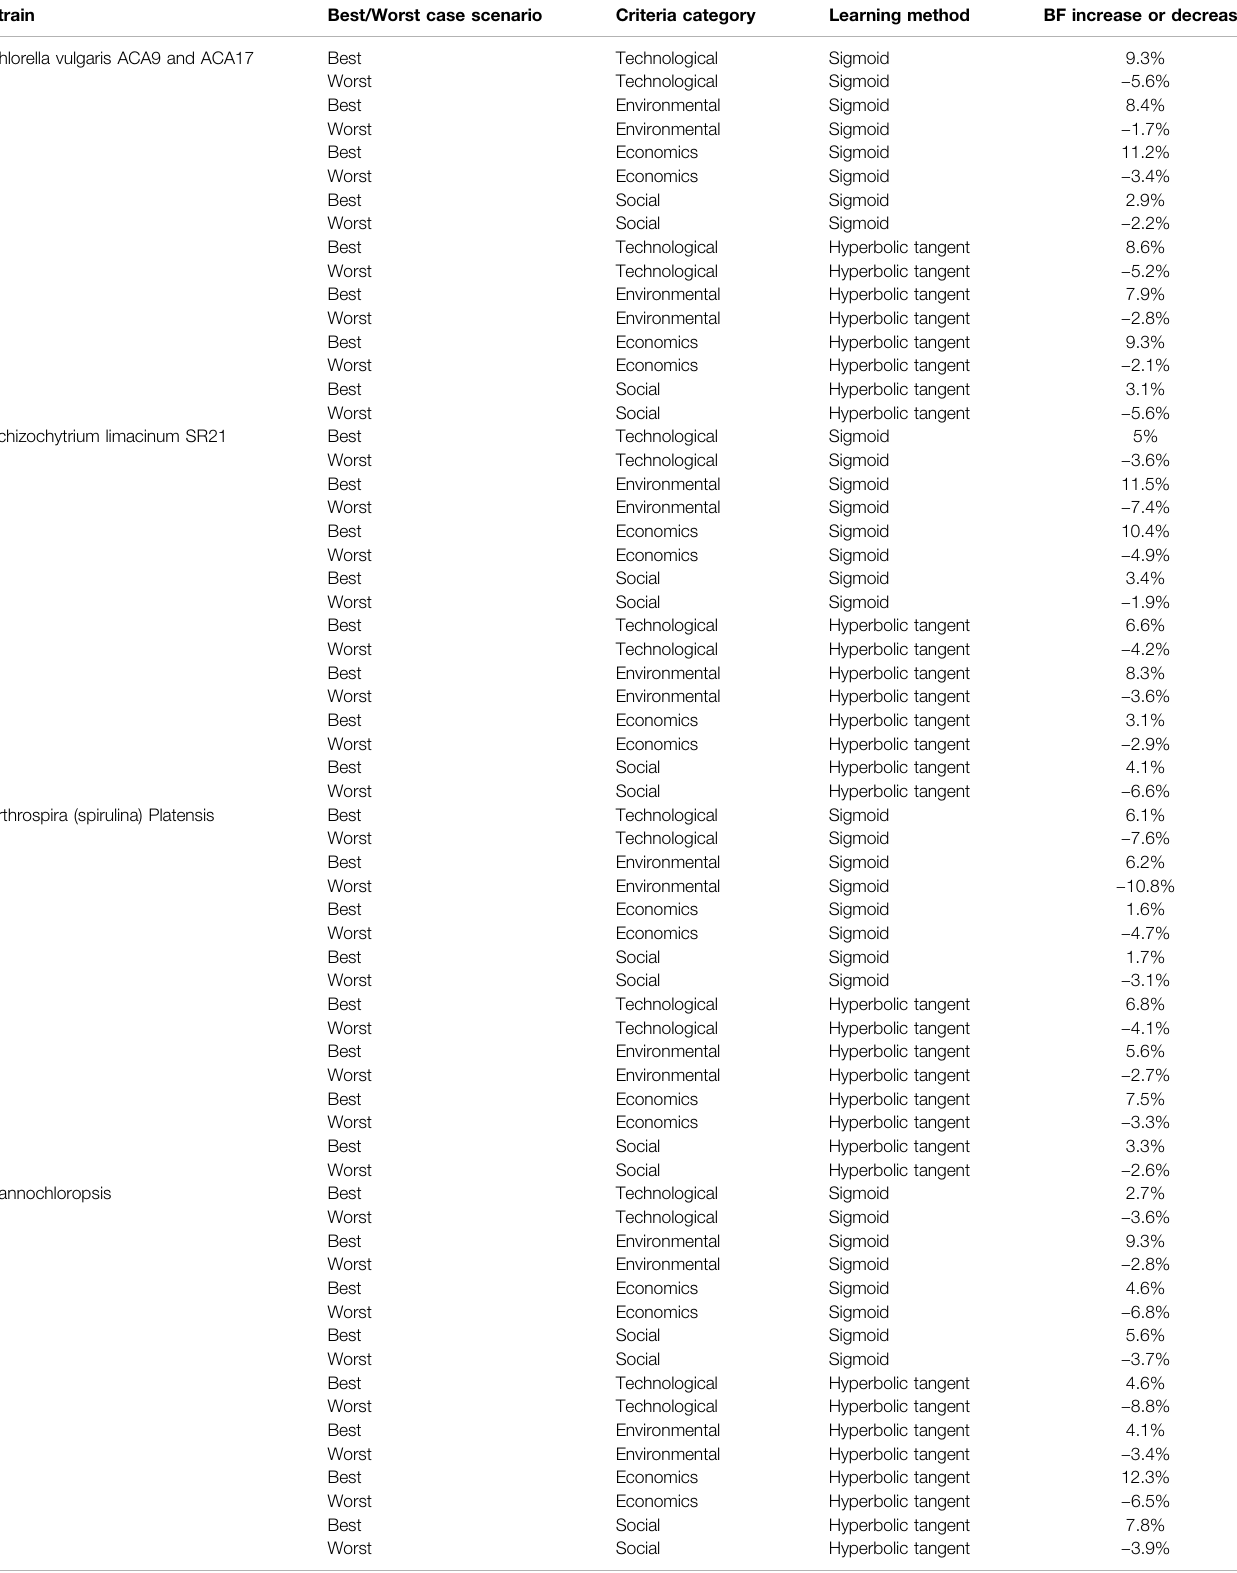
TABLE 12 | FCM best and worst case scenario